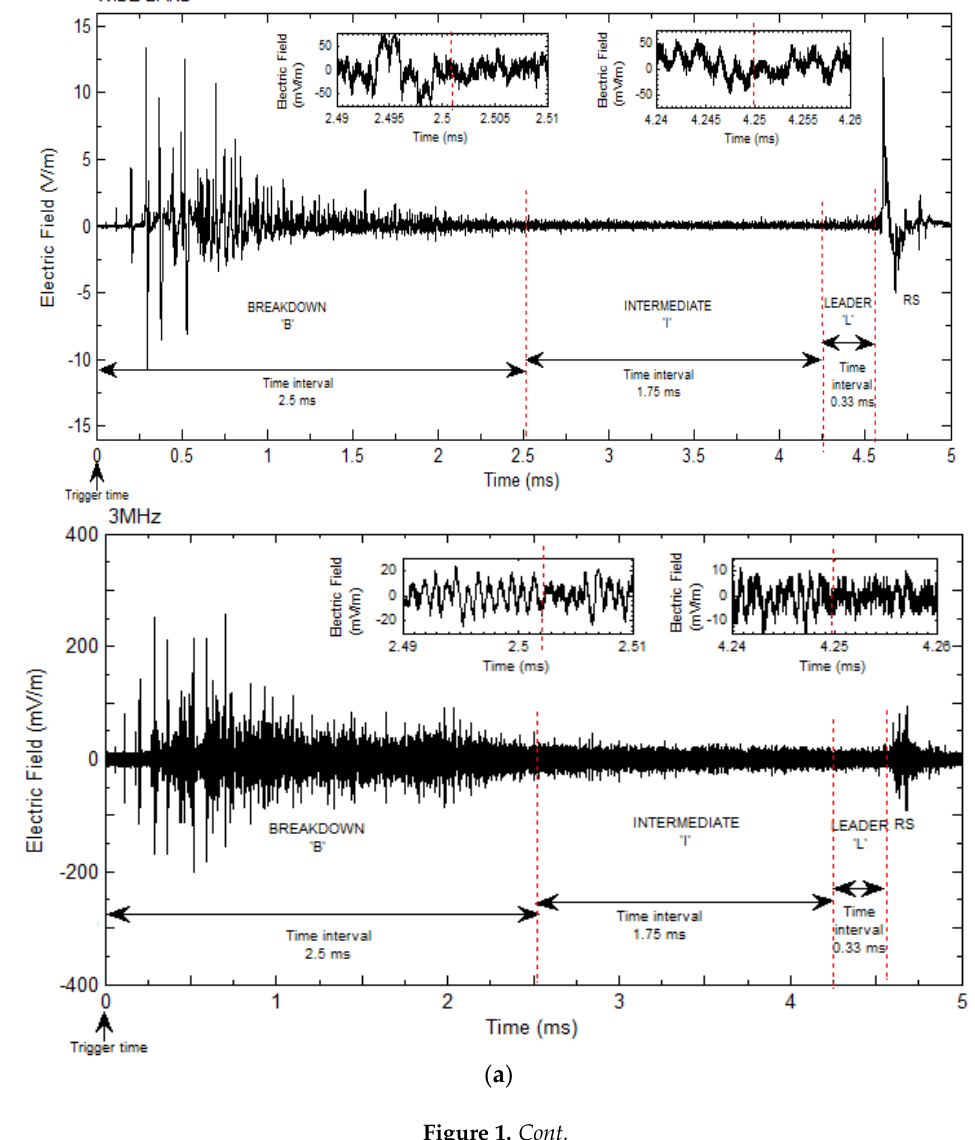
Figure 1. Cont. Figure 1.